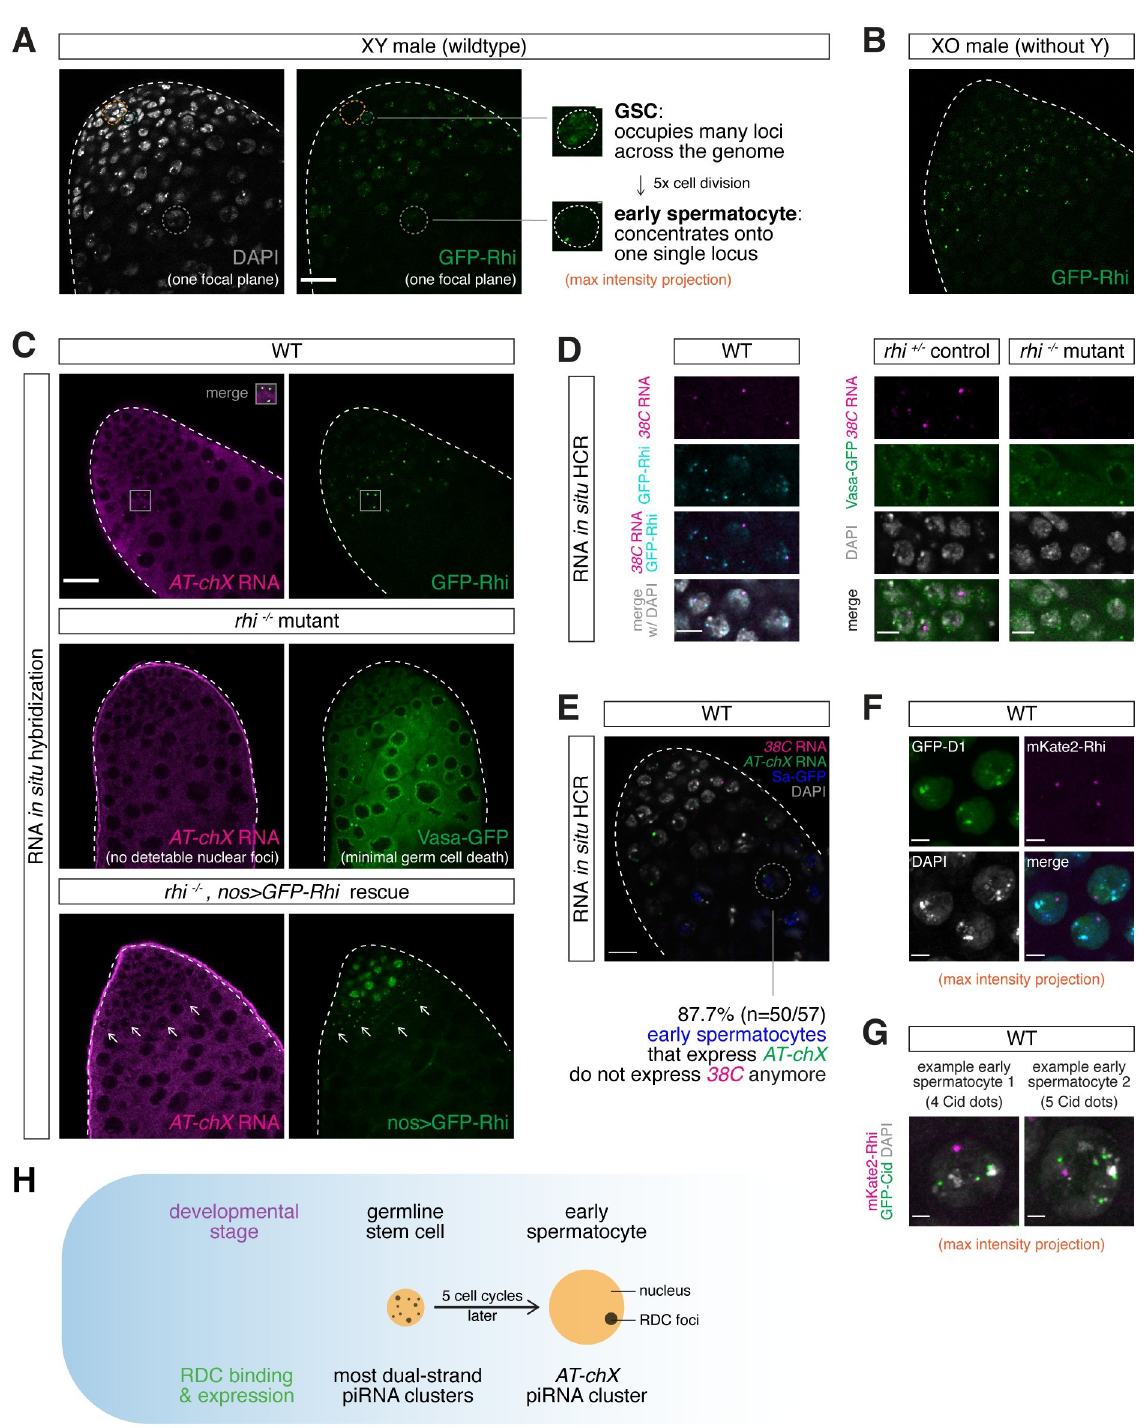
Fig 6. RDC complex enables dynamic piRNA production during early spermatogenesis. (A) Rhi localizes to multiple nuclear foci in GSCs and early spermatogonia but concentrates in a single dot in early spermatocytes. Confocal images of the apical tip of testis expressing GFP-Rhi transgene. A single focal plane is shown for DAPI and GFP-Rhi, while maximum intensity projections covering entire nuclei are shown for a GSC and an early spermatocyte on the right. Orange circle outlines the somatic hub for identification of GSCs next to it. Early spermatocyte is identified by formation of chromosome territory and increased nuclear size by DAPI. (B) Rhi localization to a single nuclear dot is not affected in early spermatocytes that lack Y chromosome. Confocal image of the apical tip of testis from XO male (that lacks Y chromosome) expressing